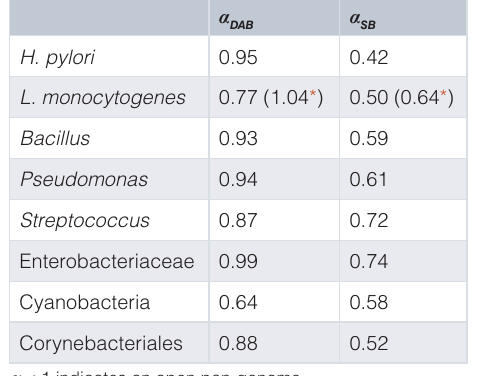
Table 4. Decay parameter α of the Heaps regression model using DAB and SB